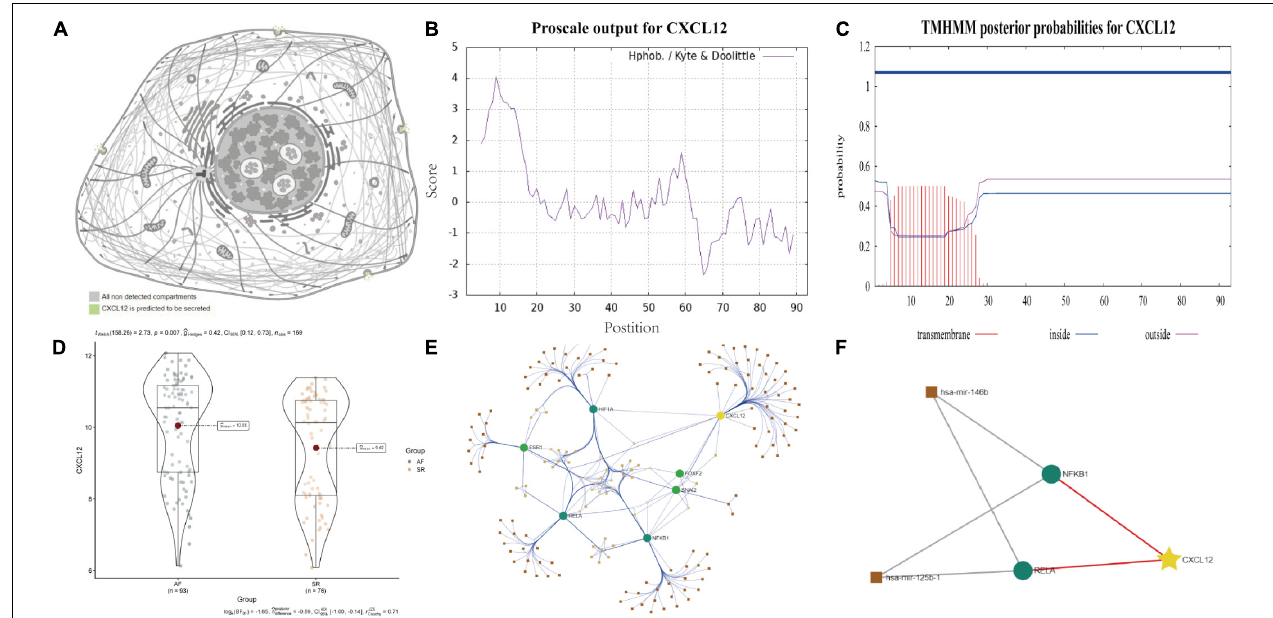
FIGURE 9 | Biological features and regulation analysis of CXCL12 in AF. (A) The prediction model of the cellular location of CXCL12 protein. (B) The hydrophilcity/hydrophobicity analysis of CXCL12 protein by ProtScale. (C) The prediction of transmembrane helices of CXCL12 by TMHMM. (D) The different mRNA expression of CXCL12 between AF and SR individuals. (E) TF-miRNA-mRNA regulation network for CXCL12 in AF. (F) Sub regulation net for CXCL12 in AF based on DE-miRNAs identified by GSE28954